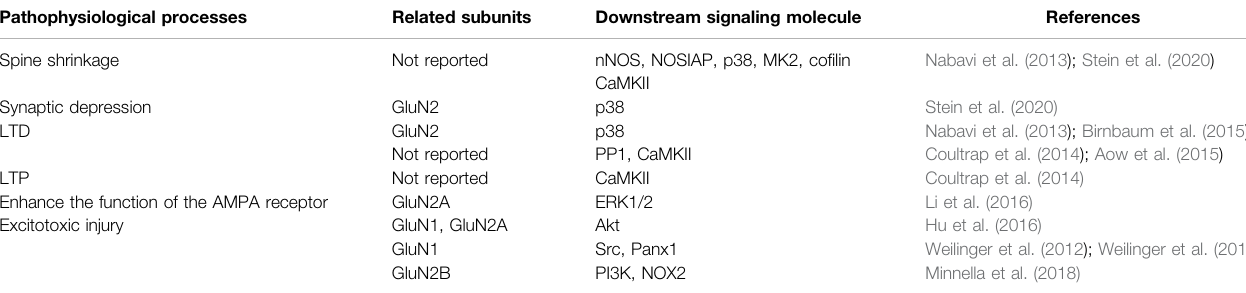
TABLE 1 | Downstream signaling molecules of metabotropic NMDA receptor